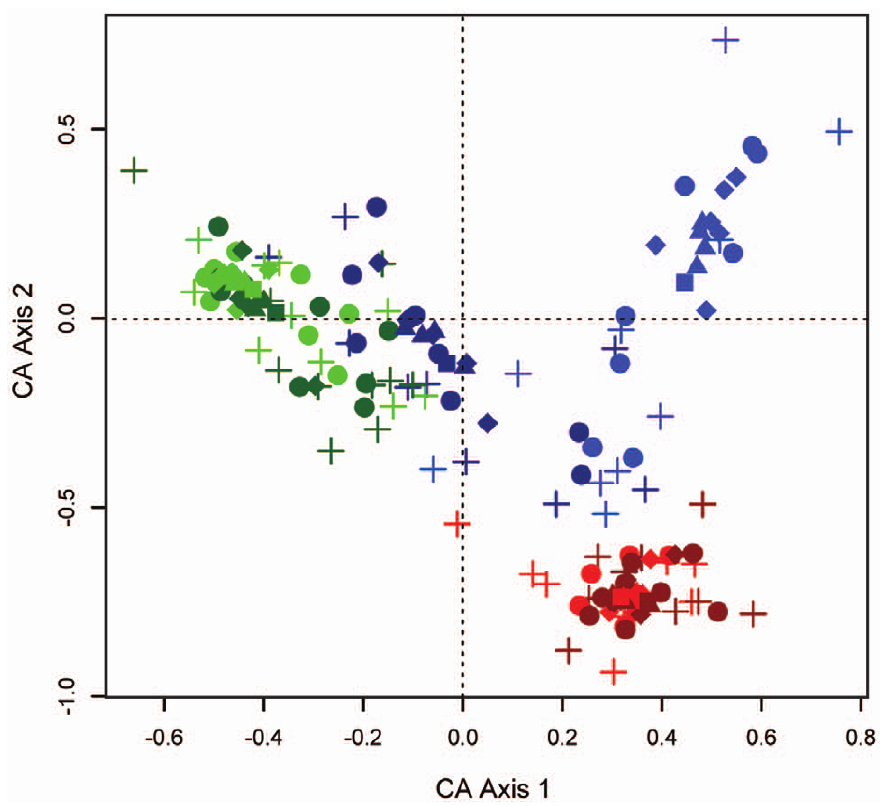
Figure 6. Correspondence analysis of time-averaged pollen influx by sampling height. Results of the CA for pollen samples aggregated over one, three, five, seven, and ten years, for each sampling height. Sampling heights are color-coded as follows: light blue (0 m), dark blue (5 m), light green (20 m), dark green (25 m), light red (40 m), and dark red (42/45 m). Sampling length is represented as crosses (1 year), circles (3 years), diamonds (5 years), triangles (7 years), and squares (10 years). The eigenvalues of axes one and two were 0.134 and 0.086 respectively. The largest sample-to-sample variation occurs at shorter sampling lengths and lower sampling heights.